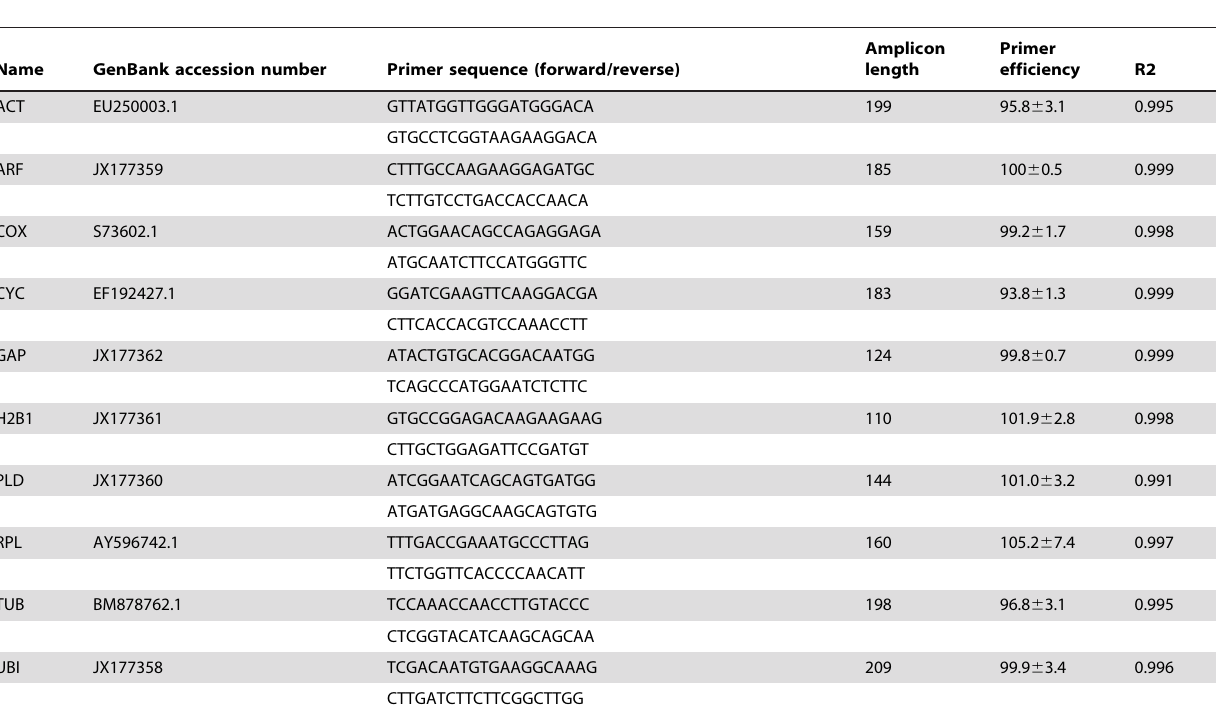
Table 1. Primer sequences of selected candidate reference genes, primers, and amplicon